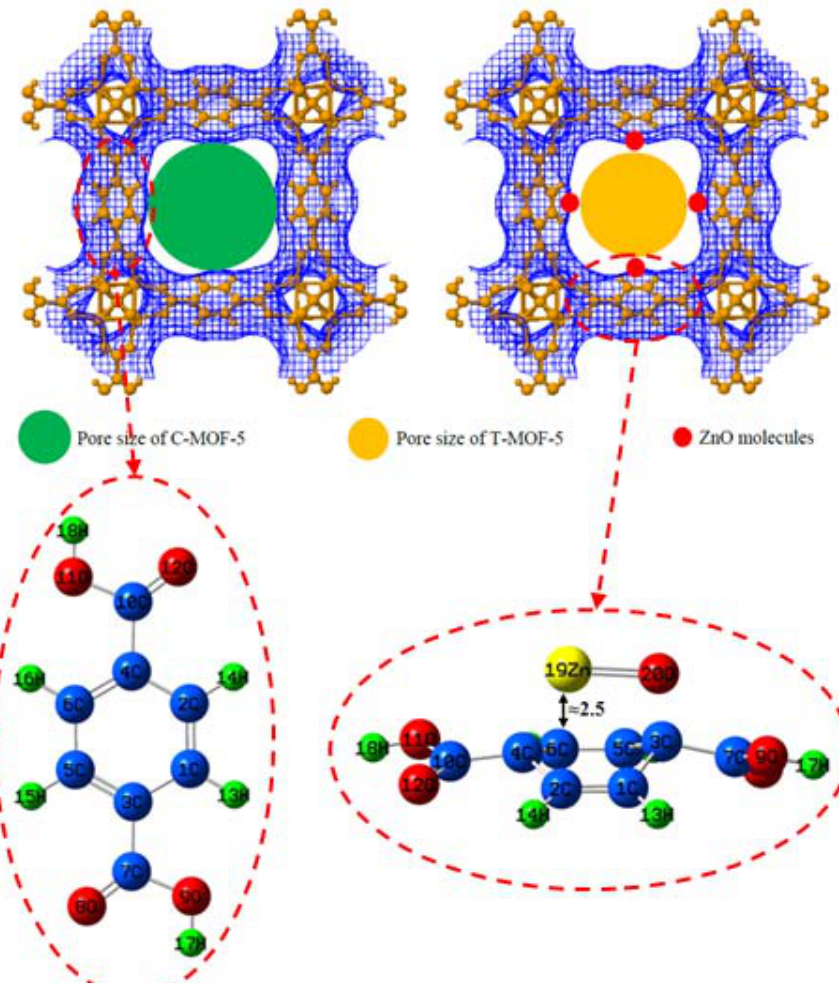
Fig. 3: C-MOF-5 and T-MOF-5 frameworks and optimized unit cell of H (carbon (blue), oxygen (red), hydrogen (green), zinc